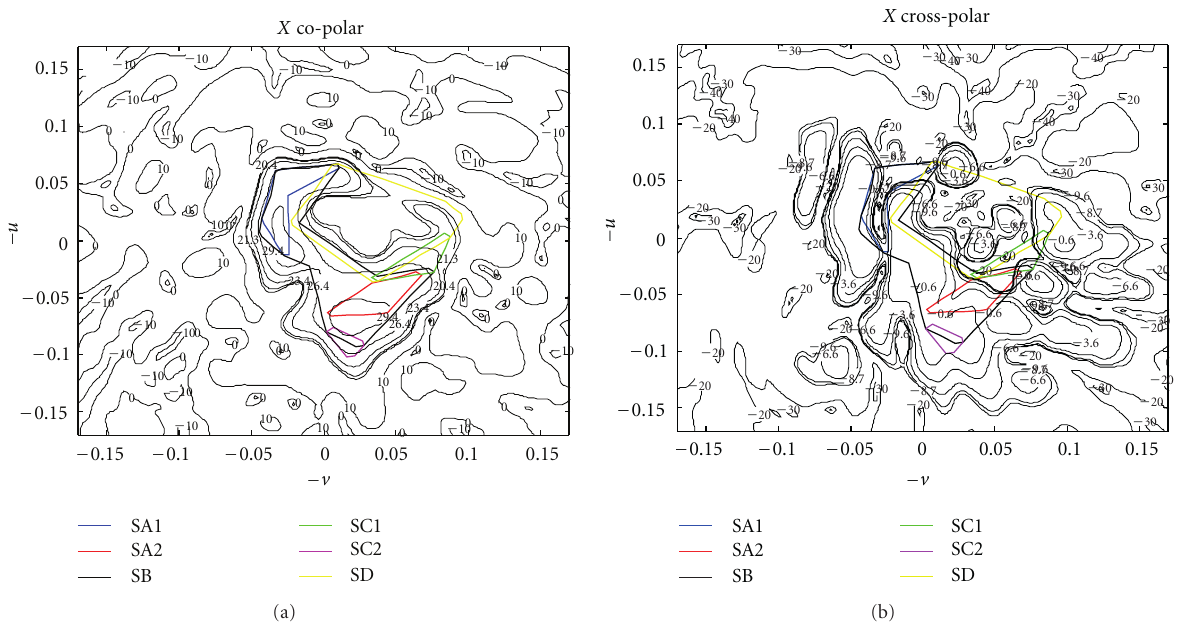
Figure 9: Copolar (a) and cross-polar (b) radiation patterns at 11.95 GHz ( X m -pol.) with the coverage template